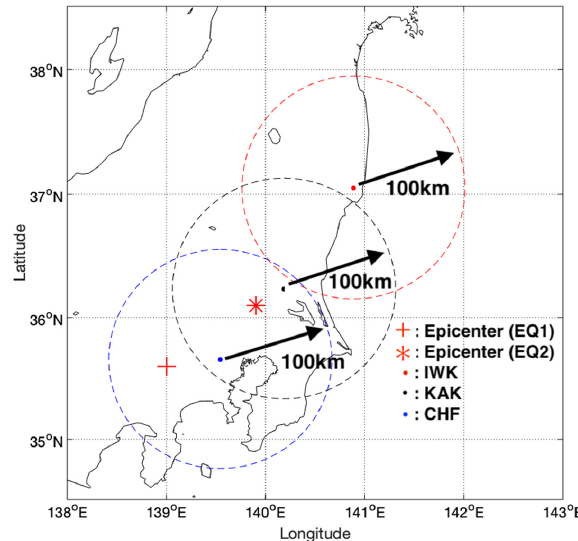
Figure 1. Relative locations of the three field sites (IWK, KAK, and CHF) for atmospheric electricity observation (shown as different coloured dots) and the epicenters of the two EQs (EQ1 is shown as a red plus and EQ2 is shown as a red diamond) referred to in this study. A circle with a radius of 100 km from each AEF site is shown as a dashed line. Table 1. Parameters of two EQs selected for this